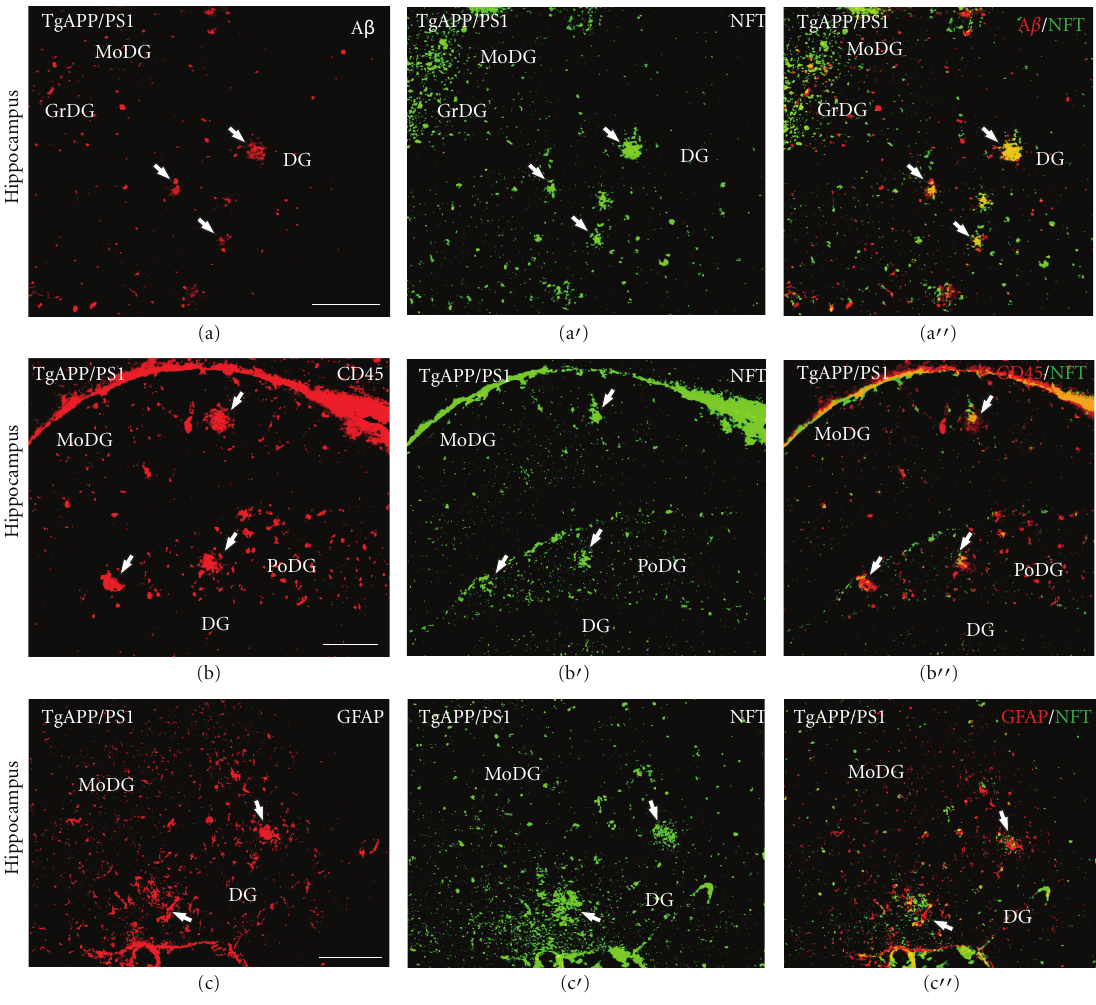
Figure 4: Association of neurofibrillary tangle-like structures with activated microglia, A β deposits, and B cells in B6C3F1/J mouse brains. Photomicrographs of transverse sections of hippocampal brain regions of 11-month-old double-transgenic APP/PS1 mice show codistribution of immunofluorescent reactivity to NFTs, A β , and GFAP. ((a)–(a (cid:3)(cid:3) )): Photomicrographs of transverse brain sections at the hippocampus show immunofluorescence to A β (red), NFTs (green), and merged channels (yellow). Note some double-labeled sparse plaques (colocalization showed by white arrows) immunofluorescence to both A β /NFTs antibodies (yellow) at the molecular layer of the dentate gyrus (a (cid:3)(cid:3) ). ((b)–(b (cid:3)(cid:3) )): Photomicrographs of transverse brain sections at hippocampus show immunofluorescence to CD45-B cells (red), NFTs (green), and merged channels (yellow). Note some codistribution of B cells and NFTs (yellow) in this region (white arrow in (b (cid:3)(cid:3) )) where NFTs (white arrow in (b (cid:3) )) are surrounded by some B cells (white arrows in (b)). ((c)–(c (cid:3)(cid:3) )): Photomicrographs of transverse brain sections at hippocampus show immunofluorescence to GFAP (red), NFTs (green), and merged channels (yellow). Note glial cells (white arrows in (c)) surrounding the NFTs (white arrows in (c (cid:3) )) at the dentate gyrus, although no colocalization (yellow) was observed (c (cid:3)(cid:3) ). For abbreviations, see list. Scale bar: 100 μ